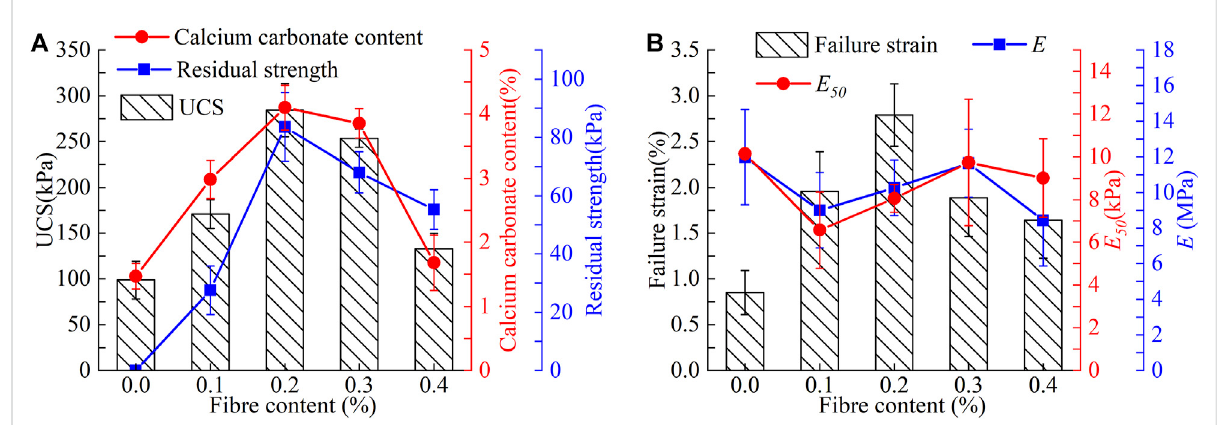
FIGURE 5 Effect of fi ber content on the indicators of EICP-treated sand: (A) uncon fi ned compressive strength, residual strength and calcium carbonate content; (B) failure strain, E and E 50